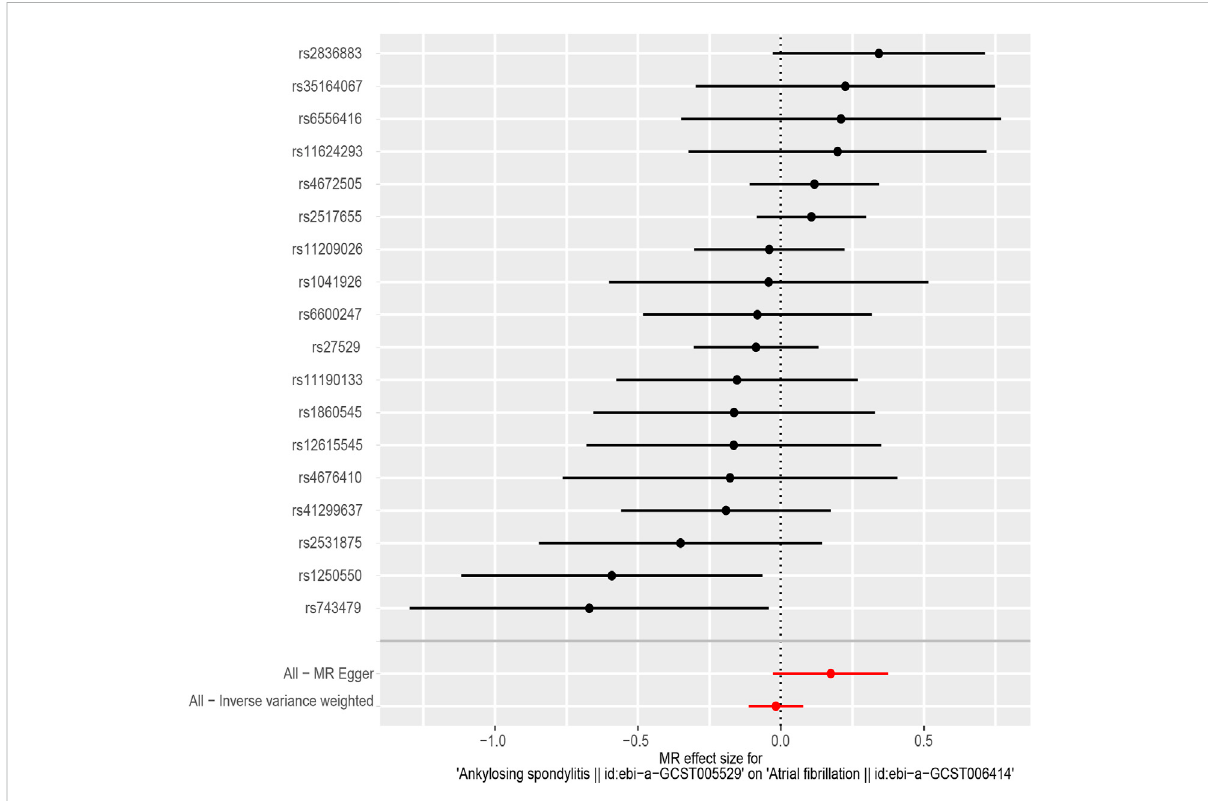
FIGURE 2 The forest plot of Mendelian randomization analysis for 18